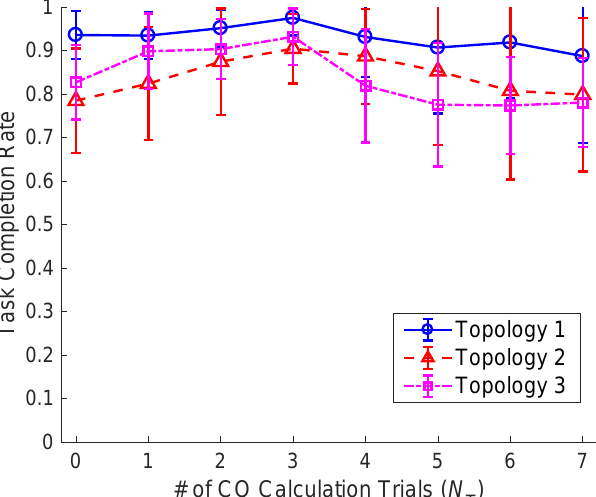
Figure 11. Task completion rate with respect to connection quality (CQ) calculation trials where the number of tasks is